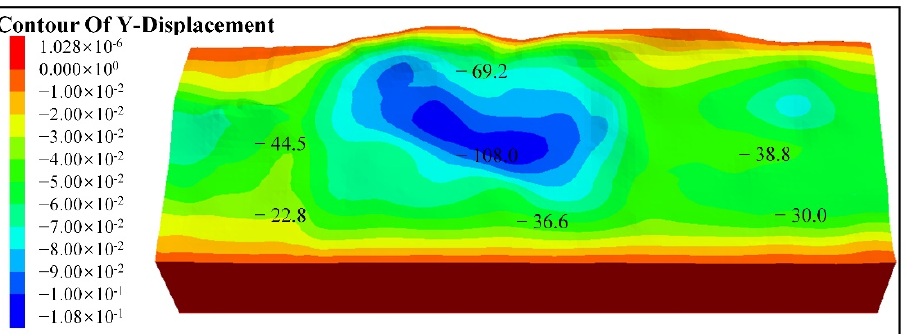
Figure 10. Simulated displacement nephogram based on the inversion results.